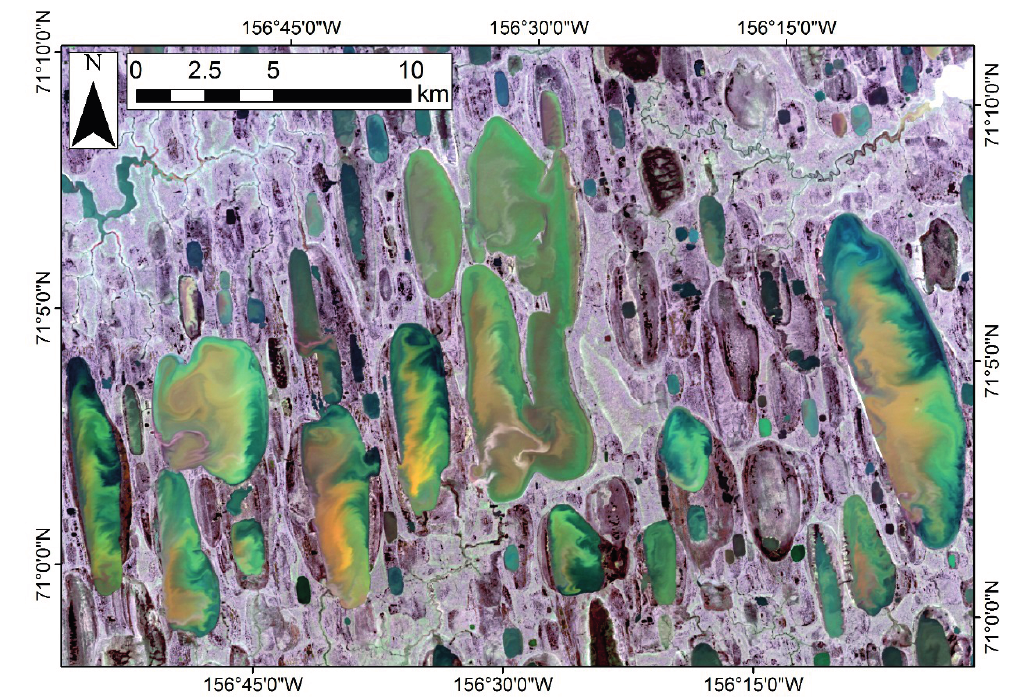
Figure 1. Natural color Landsat 8 image showing wide-spread occurrence of gyres in oriented thermokarst lakes on the outer portion of the Arctic Coastal Plain (ACP), approximately 25 km SSE of Barrow, Alaska on 10 July